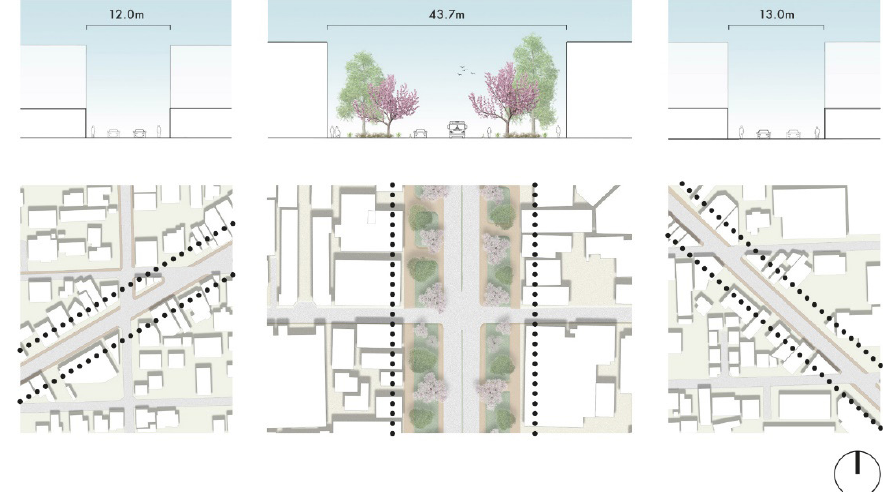
Figure 6. From left to right sections (above) and plans (below) of Fujimi-, Daigaku- and